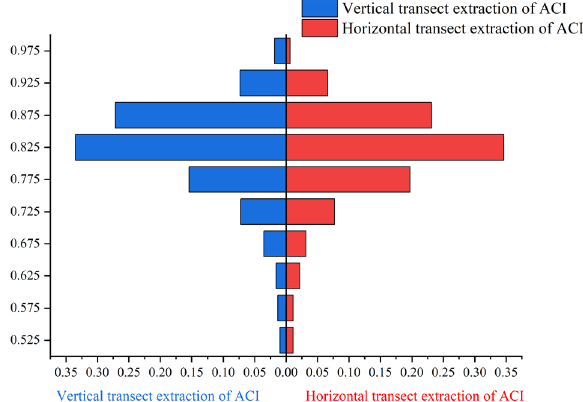
Figure 10. Histogram of ACI frequency distribution of all paired samples.